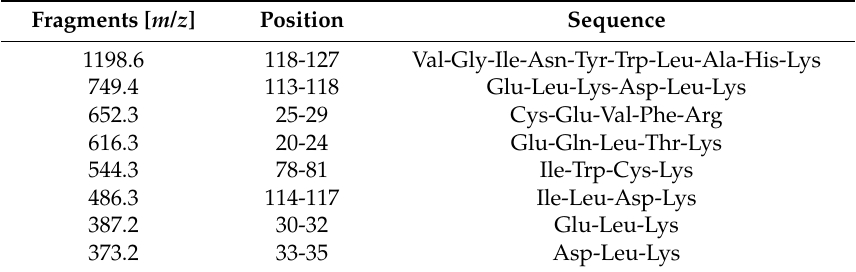
Table 1. Fragments, position in protein, and sequence of detectable peptides after tryptic digestion. Detection by use of high resolution mass spectrometry.